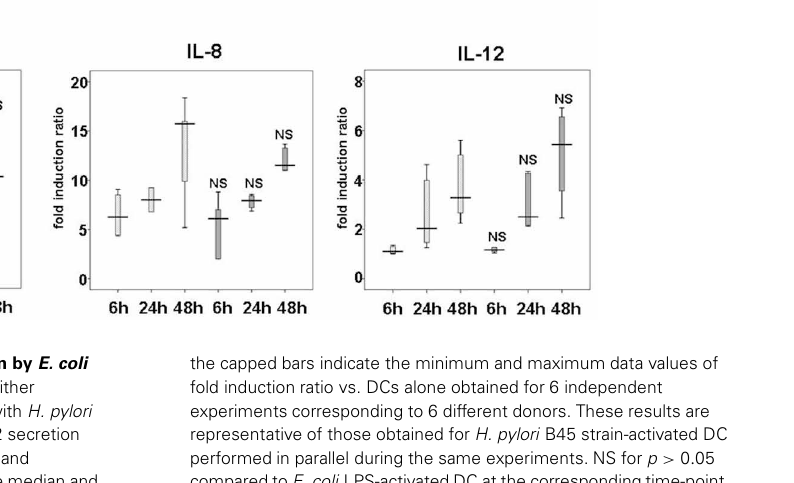
the capped bars indicate the minimum and maximum data values of fold induction ratio vs. DCs alone obtained for 6 independent experiments corresponding to 6 different donors. These results are representative of those obtained for H. pylori B45 strain-activated DC performed in parallel during the same experiments. NS for p > 0 . 05 compared to E. coli LPS-activated DC at the correspondingtime-point.